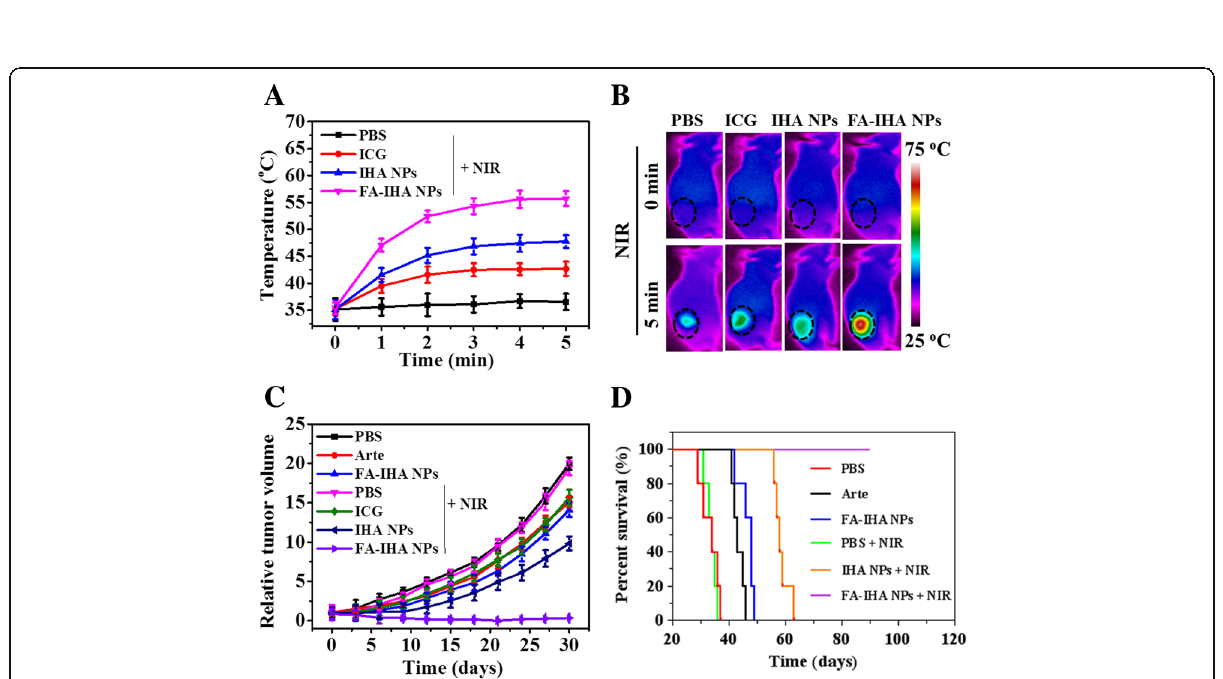
Fig. 9 a Tumor region temperatures in tumor-bearing mice after tail vein injection of PBS, ICG, IHA NPs, and FA-RIPNPs at 24 h under 5 min of NIR irradiation (808 nm, 1 W/cm 2 ). b Thermal images of tumor-bearing mice after tail vein injection of PBS, ICG, IHA NPs, and FA-RIPNPs at 24 h under 5 min of NIR irradiation (808 nm, 1 W/cm 2 ). c HepG2 xenograft tumors growth profile after intravenous injection of PBS, Arte, ICG, IHA NPs, and FA-RIPNPs with or without 5 min of NIR irradiation (808 nm, 1 W/cm 2 ). d Survival rate of tumor-bearing mice after tail vein injection with PBS, free Arte, ICG, IHA NPs, and FA-RIPNPs with or without 5 min of NIR irradiation (808 nm, 1 W/cm 2